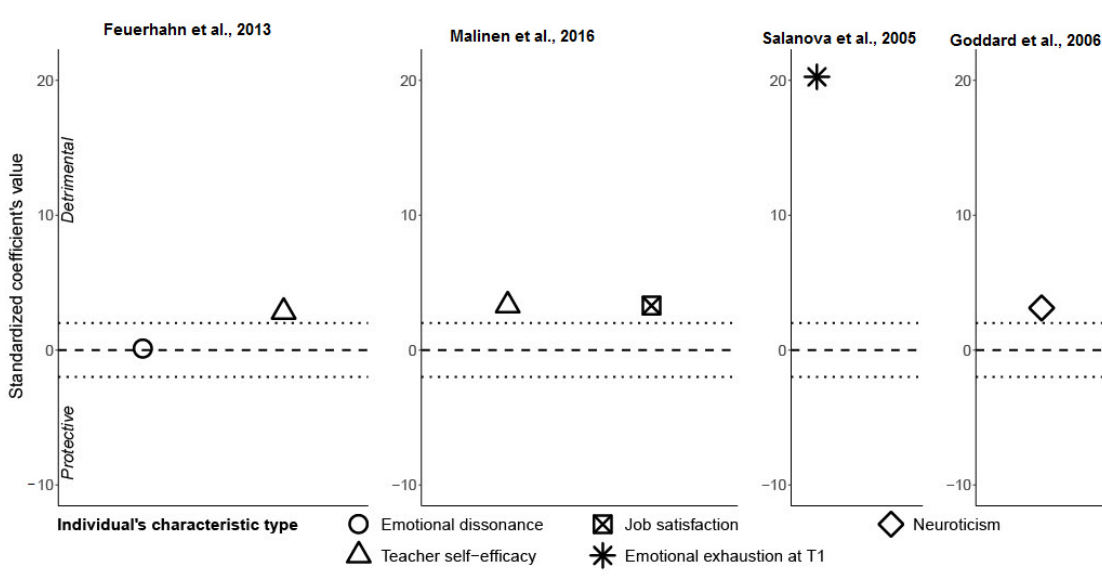
Figure Figure 4. Four studies representing individual characteristics as burnout determinants (Feuerhahn et al., 2013; Malinen et al., 2016; Salanova et al., 2005; Goddard et al., 2006) [48,49,51,52].